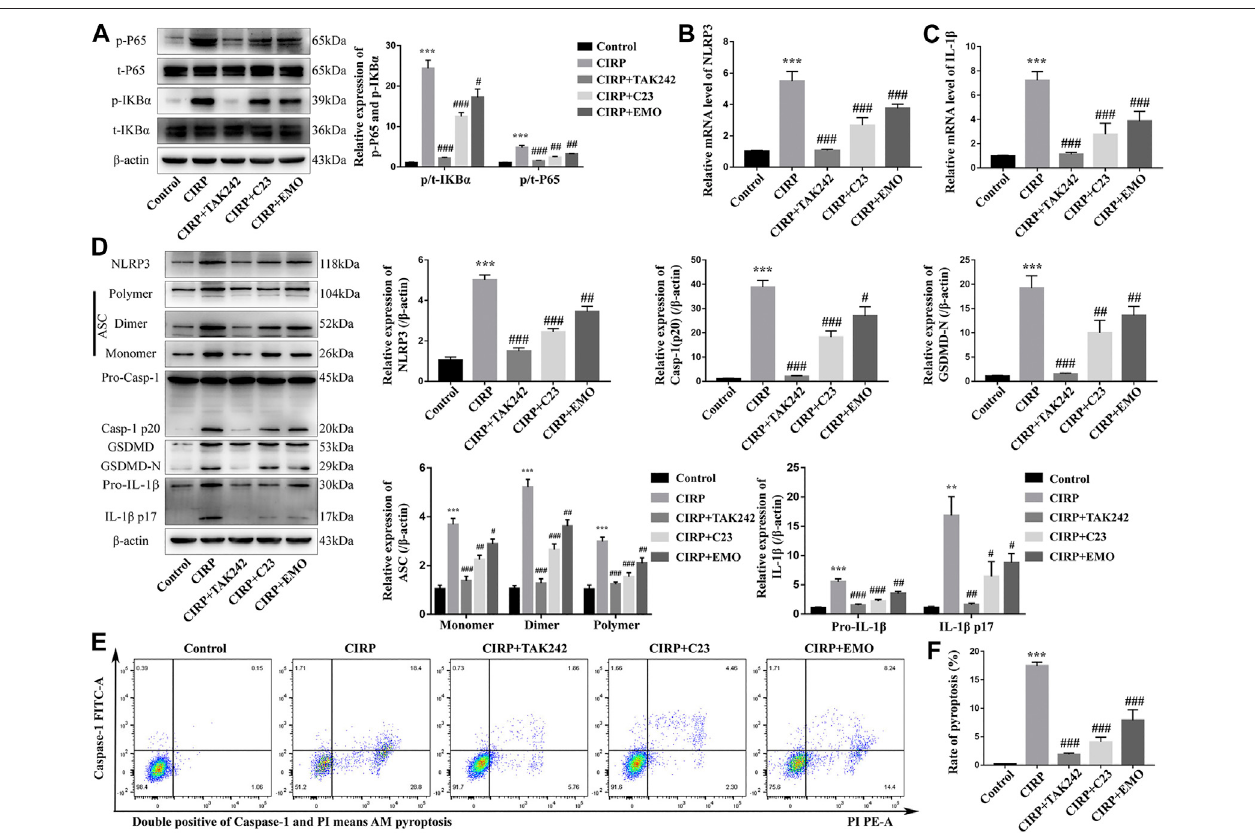
FIGURE 5 | Treatment with emodin, like C23, mitigates the CIRP-activated NF- κ B signaling, NLRP3 in fl ammasome formation, and pyroptosis in NR8383 cells. NR8383cellsweretreatedwithvehicleasthecontrol,orCIRPinthepresenceofTAK242,emodinorC23for6 h. (A) WesternblotanalysisoftherelativelevelsofNF- κ Bp65 and IKB α to the control β -actin expression and their phosphorylation in the different groups of NR8383 cells. (B, C) Quantitative RT-PCR analysis of the relative levels of NLRP3 and IL-1 β to the control GAPDH mRNA transcripts in the different groups of NR8383 cells. (D) Western lot analysis of the relative levels of NLRP3, ASC (Monomer, Dimer, Polymer), caspase1 (Pro-Casp-1, Casp-1 p20), GSDMD (GSDMD, GSDMD-N), and IL-1 β (Pro-IL-1 β , IL-1 β p17) to β -actin expression in NR8383 cells. (E, F) Flow cytometry analysis of the frequency of NR8383 cells undergoing pyroptosis in NR8383 cells. The data are representative images, fl ow cytometry charts or expressedasmean ± SDofeachgroupofcellsfromthreeseparateexperiments;*** p < 0.001vs.theControlgroup. # p < 0.05, ## p < 0.01, ### p < 0.001vs.theCIRPgroup.